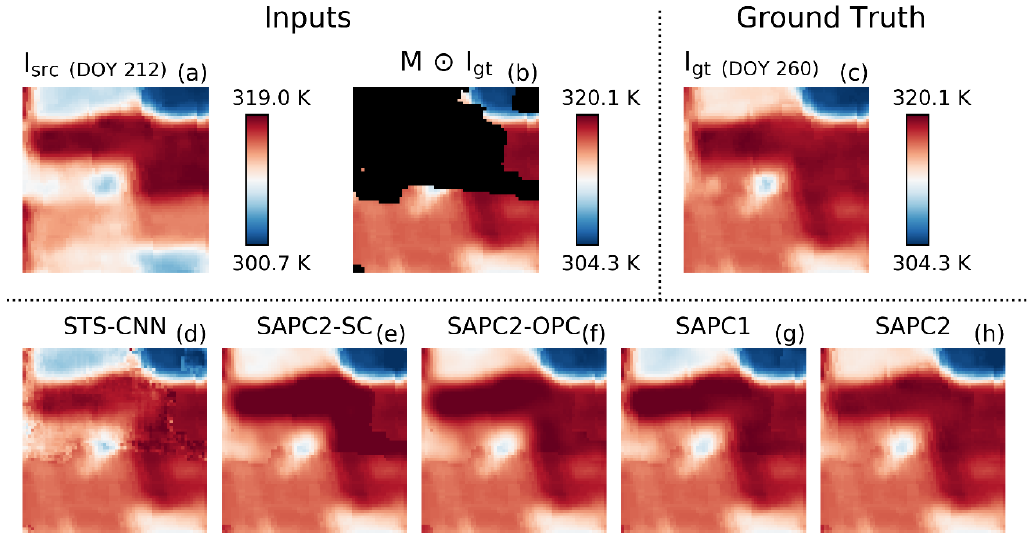
Figure 13. The same as Figure 9 but for Case 5 (acquisition DOYs for source and target inputs are 212 and 260, respectively). The masked fraction of the target image ( b ) is 0.476. The correlation coefficient between source ( a ) and ground truth ( c ) images is 0.915.